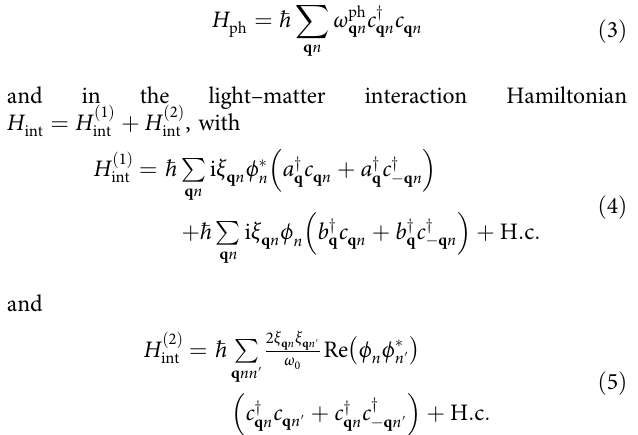
collective-dipole modes that extend across the A and B sub- lattices, respectively, with wavevector q in the fi rst Brillouin zone (see Fig. 2a). Finally, the function f